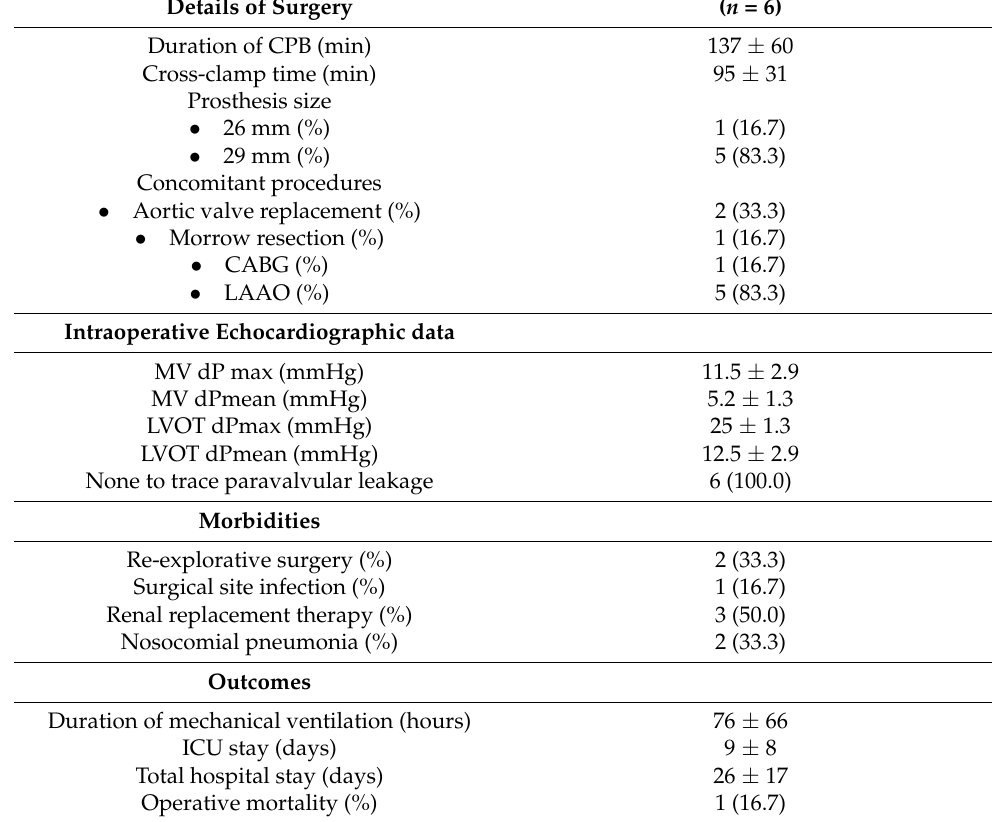
Table 2. Intraoperative and postoperative